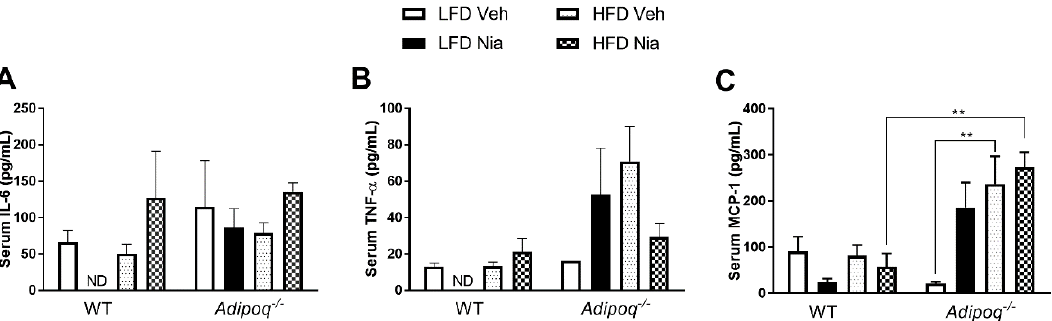
Figure 6. Effects of HFD and niacin on systemic markers of inflammation. Serum concentrations of the proinflammatory cytokines IL-6 ( A ) and TNF- α ( B ), and the macrophage chemokine MCP-1 ( C ), in wild-type and Adipoq -/- mice. Data are presented as mean + SEM. ND: not detectable. ** p ≤ 0.01; WT LFD Veh, n = 8; WT LFD Nia, n = 8; WT HFD Veh, n = 8; WT HFD Nia, n = 7; Adipoq -/- LFD Veh, n = 6;